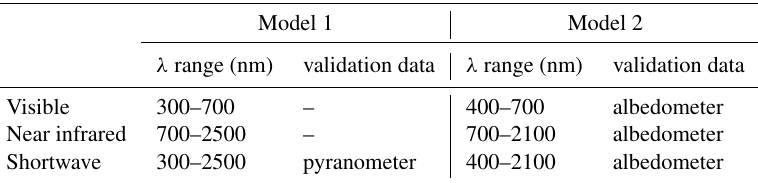
Table 4. Difference between the wavelength ranges of the retrievals from the two MLANN models. The validation of retrieval results are shown in Figs. 3 and 6 and Table A2.